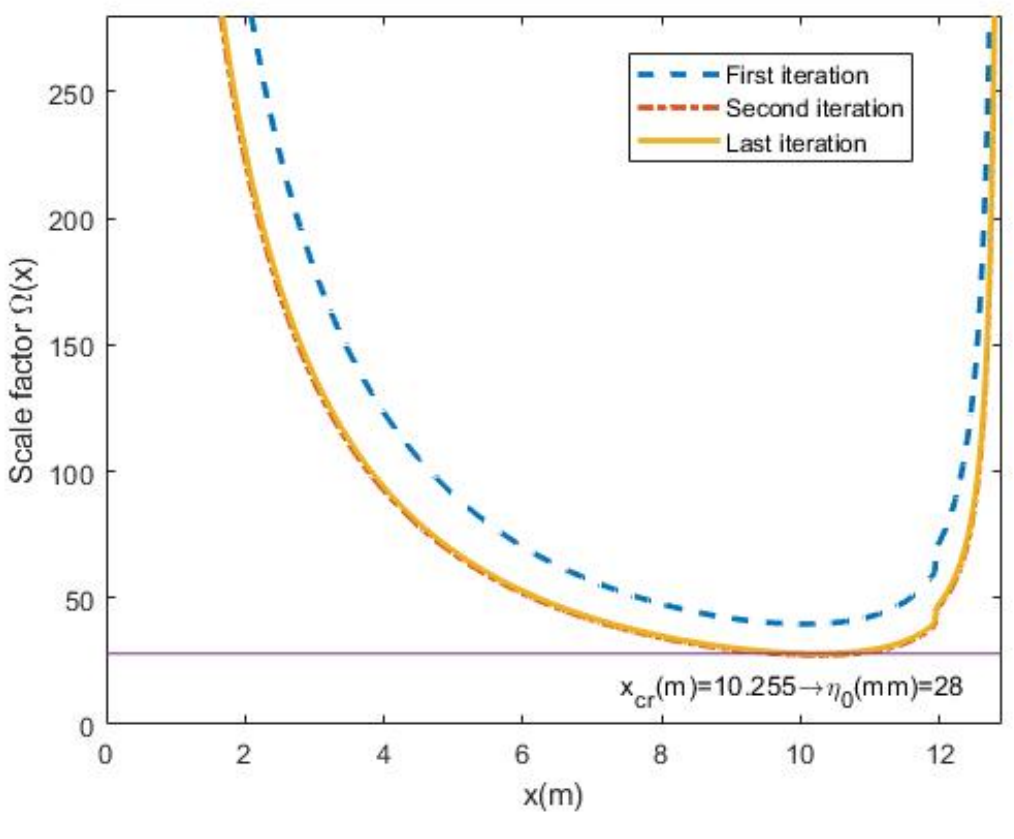
Figure 12. Example 4(a): the scale factor Ω ( x ). Utilization factor U N + M = 1.0. Figure 12. Example 4.1: the scale factor Ω (x) . Utilization factor U N+M = 1.0. Table 4. Example 4: key values for each Table 4. Example 4: key values for each iteration.